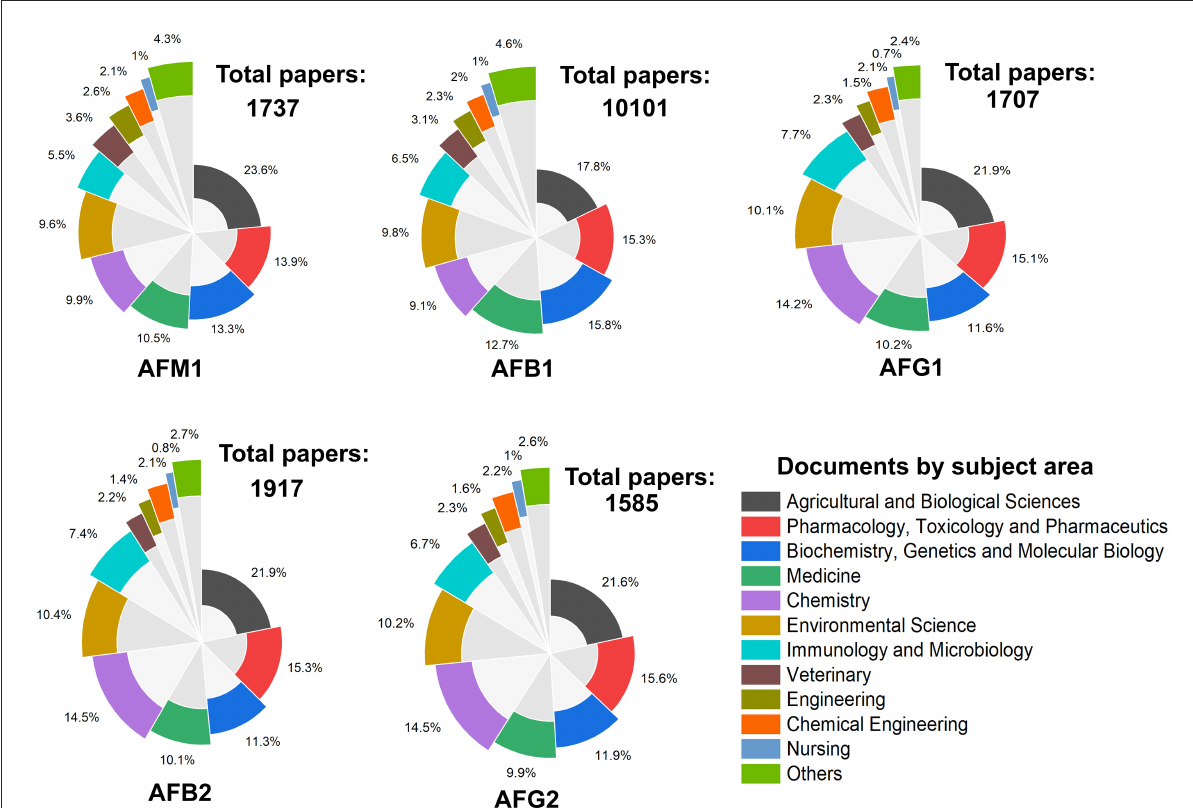
FIGURE3 The frequency of studies on AFs metabolites from 1990 to 2021. Each plot represents the number of papers published on searched keywords and the percentage of documents per subject